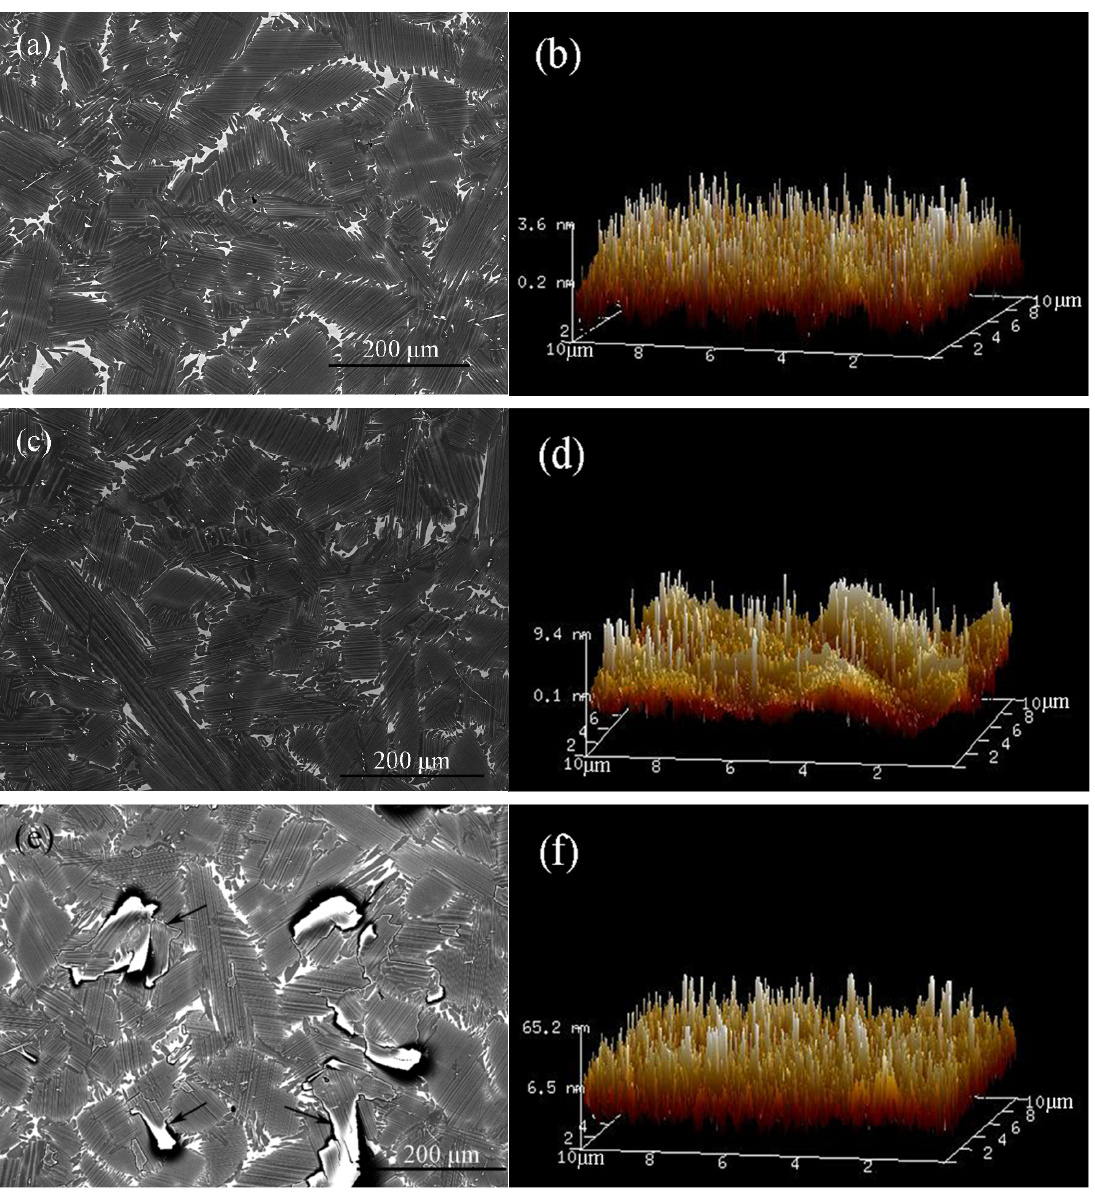
Figure 2. SEM and AFM images of the irradiated samples with helium ions to a fluence of ( a , b ) 0; ( c , d ) 1 × 10 21 ions/m 2 at 298 K; ( e , f ) 1 × 10 21 ions/m 2 at 773 K.